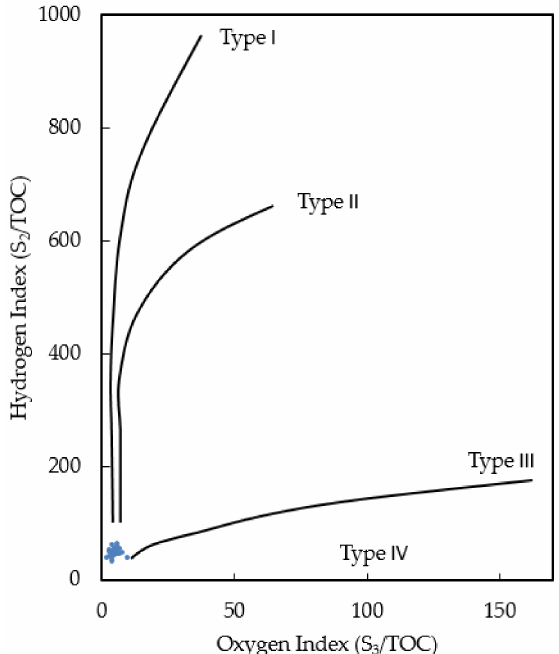
Figure 1. Modified van Krevelen diagram of the Eagle Ford Shale samples.